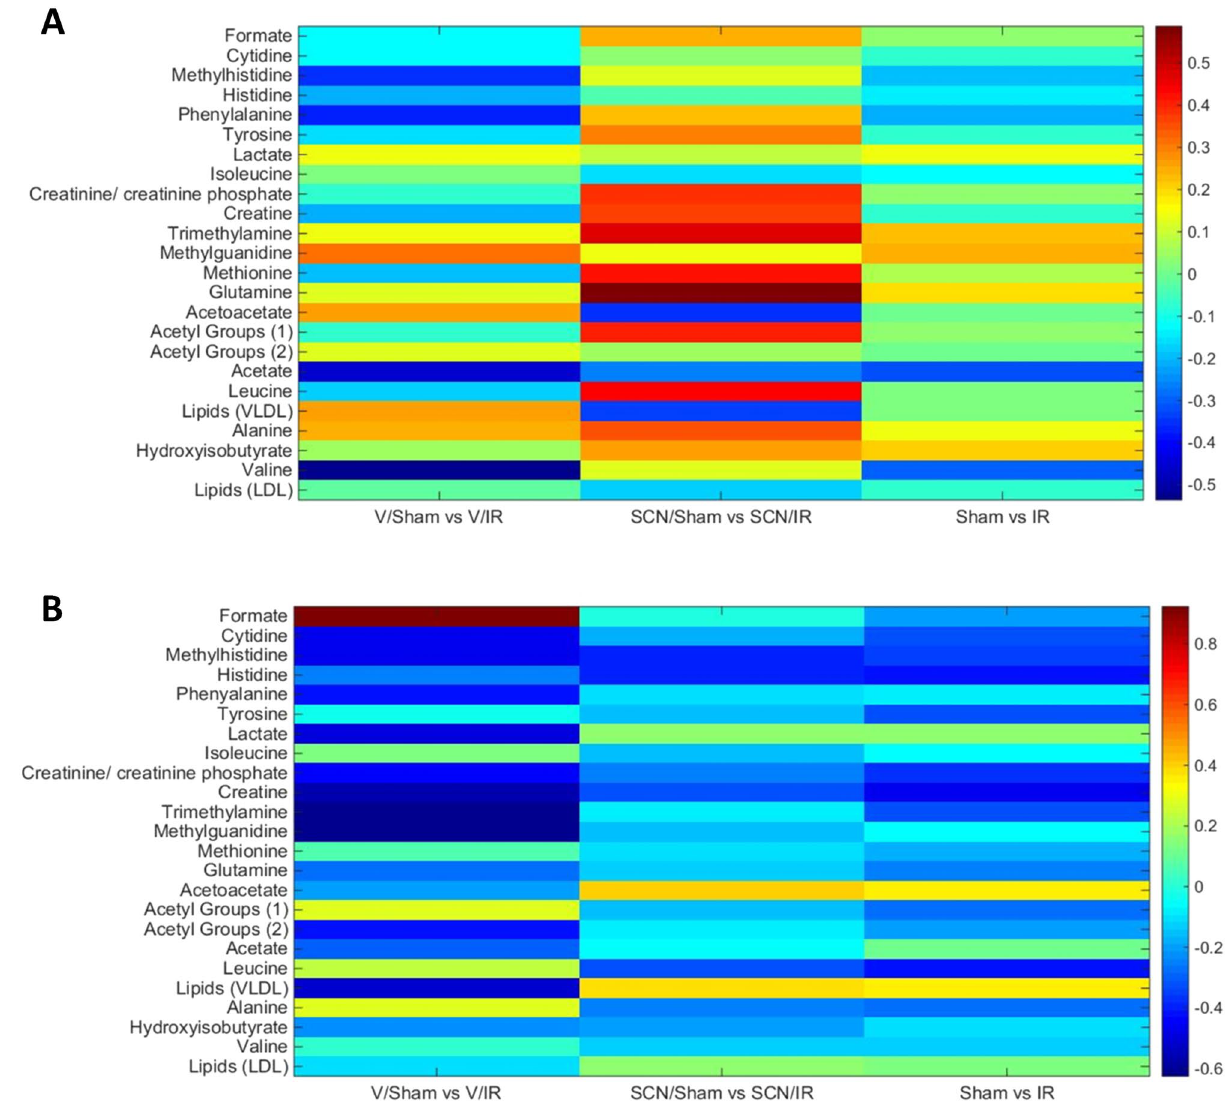
Figure 10. (A) Heatmap of major endogenous metabolites quantified in rat serum by 1 H-NMR, and their change in expression at 24 h post-surgery. The first column shows the fold change in vehicle/IR rats relative to the vehicle/sham controls, the second column shows the fold change in SCN − -supplemented/IR rats relative to the SCN − -supplemented/sham operated controls, and the third column shows the fold change for all IR rats relative to all shams. (B) As panel (A) except for animals at 4 weeks post-surgery. In both cases, hot colors (red) indicates an increased fold change, while cold colors (blue) indicates a reduced fold